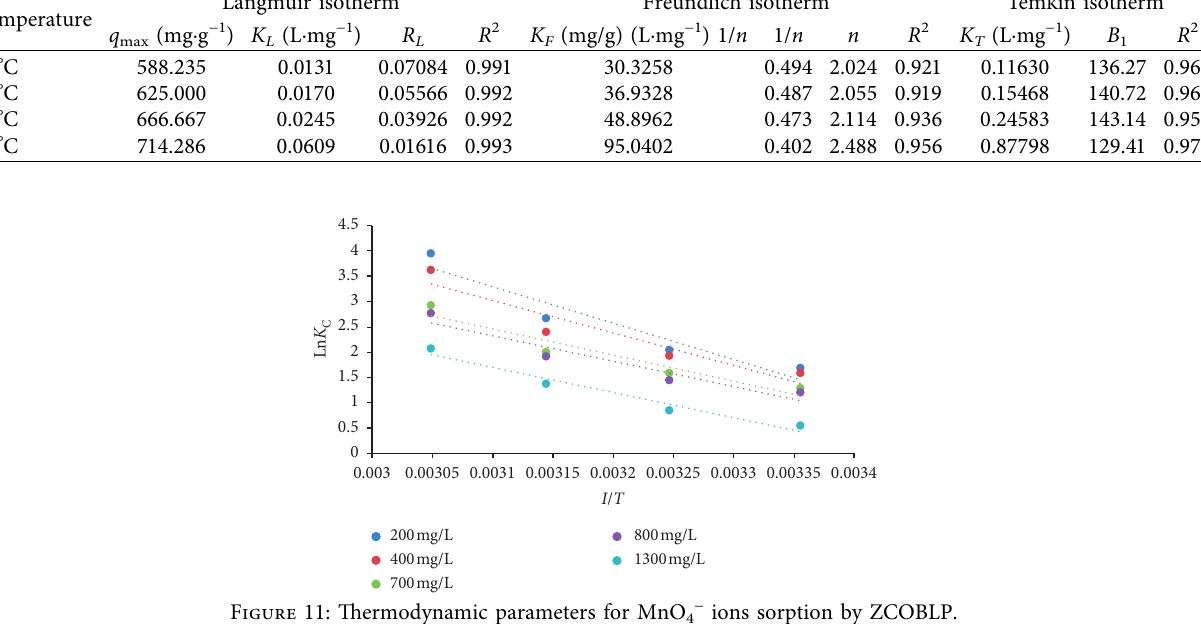
Table 5: Constants of isotherms for MnO